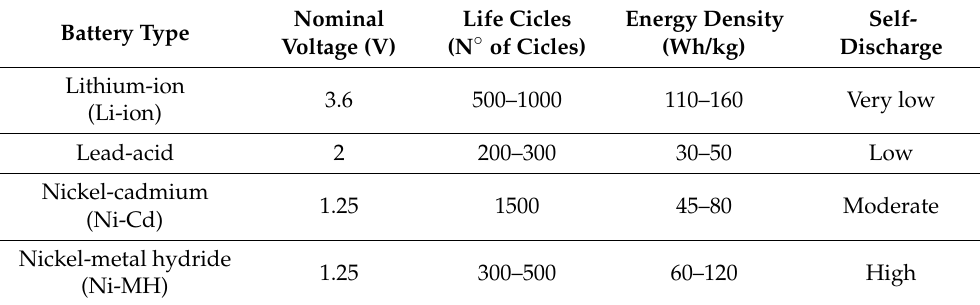
Table 1. Comparison of characteristics between the different types of batteries according to